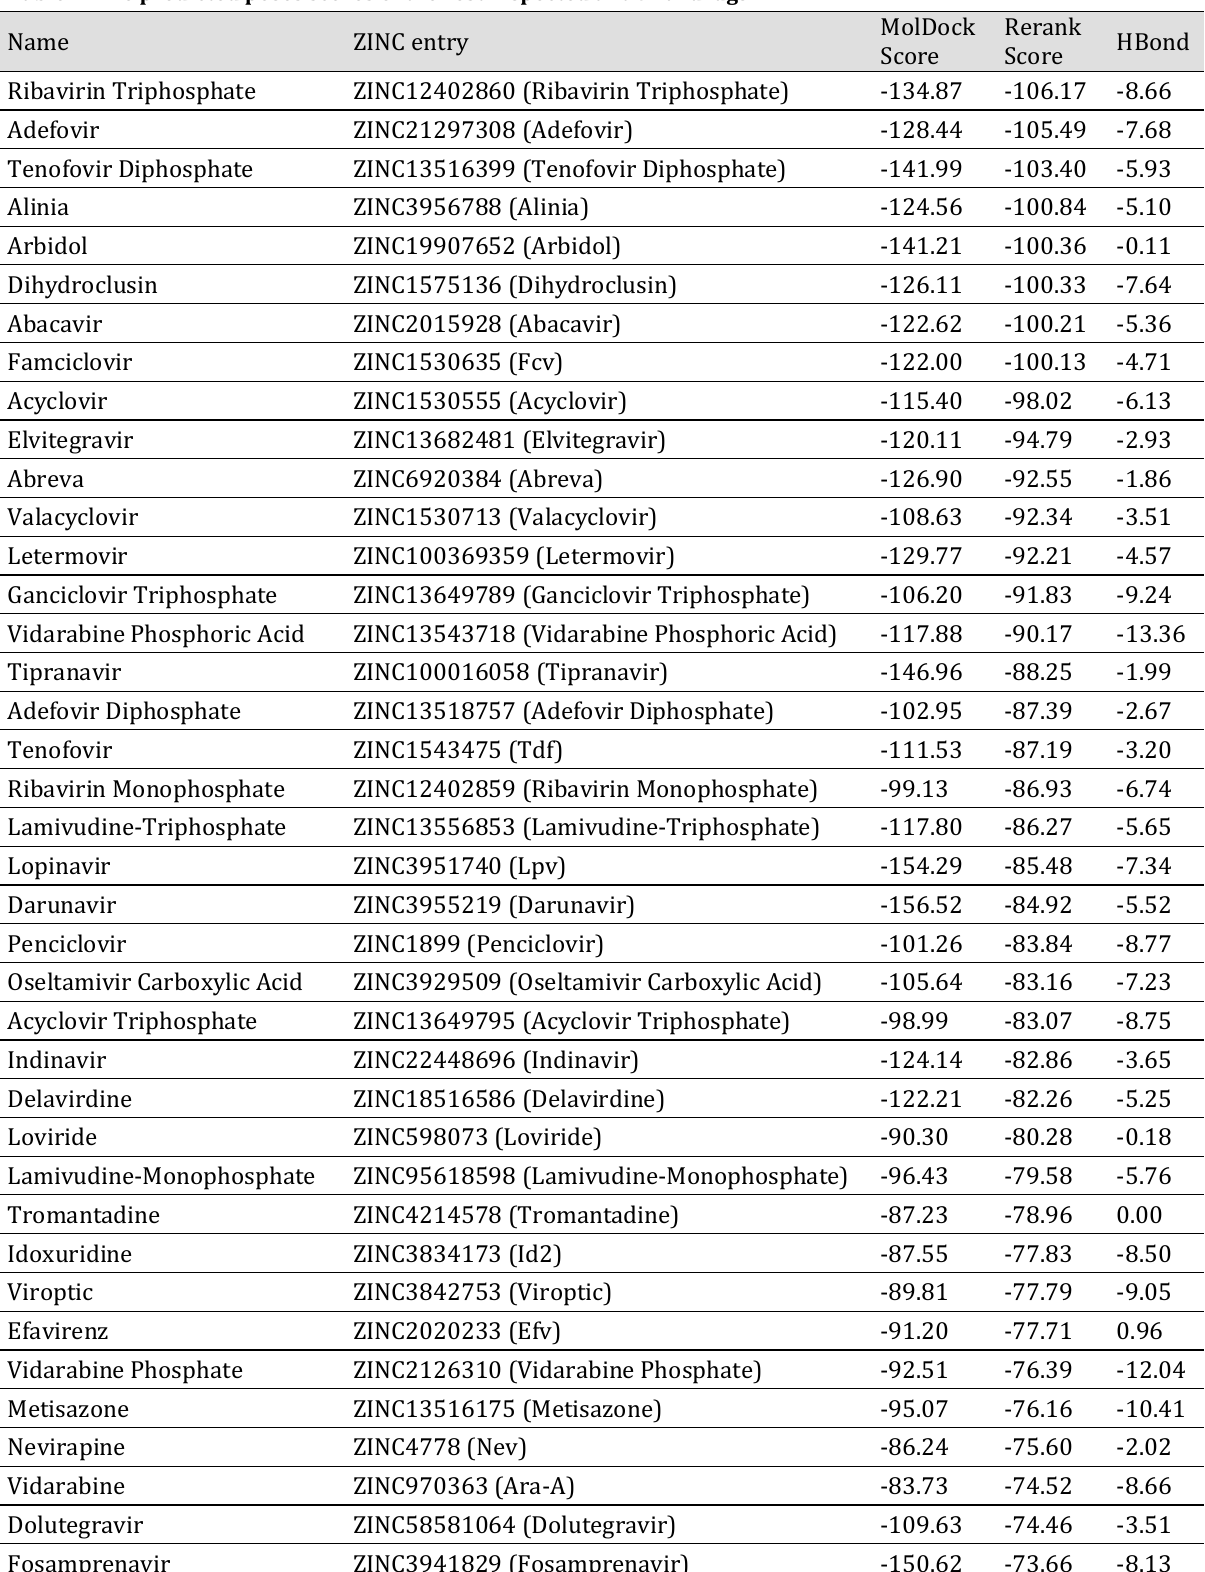
Table 2. The predicted poses scores of the rest inspected antiviral